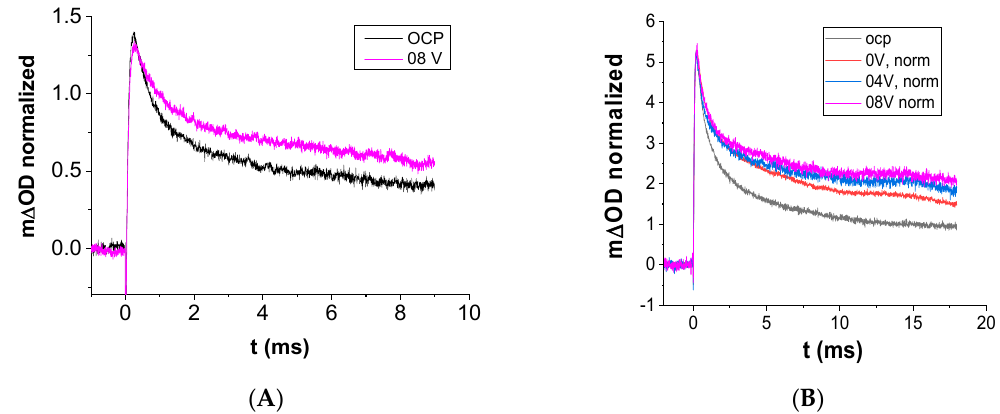
Figure 12. Kinetic evolution of SnO 2 (e − )- 1 (h + ) ( A ) and SnO 2 (e − )- 2 (h + ) ( B ). The charge-separated state was observed following ns laser excitation at 532 nm in 0.1 M HClO 4 at OCP (black line) and under different applied biases (values versus Pt); 1 M Ω oscilloscope resistance. (B) The traces have been normalized to the maximum Δ OD observed at 0.8 V versus Pt.